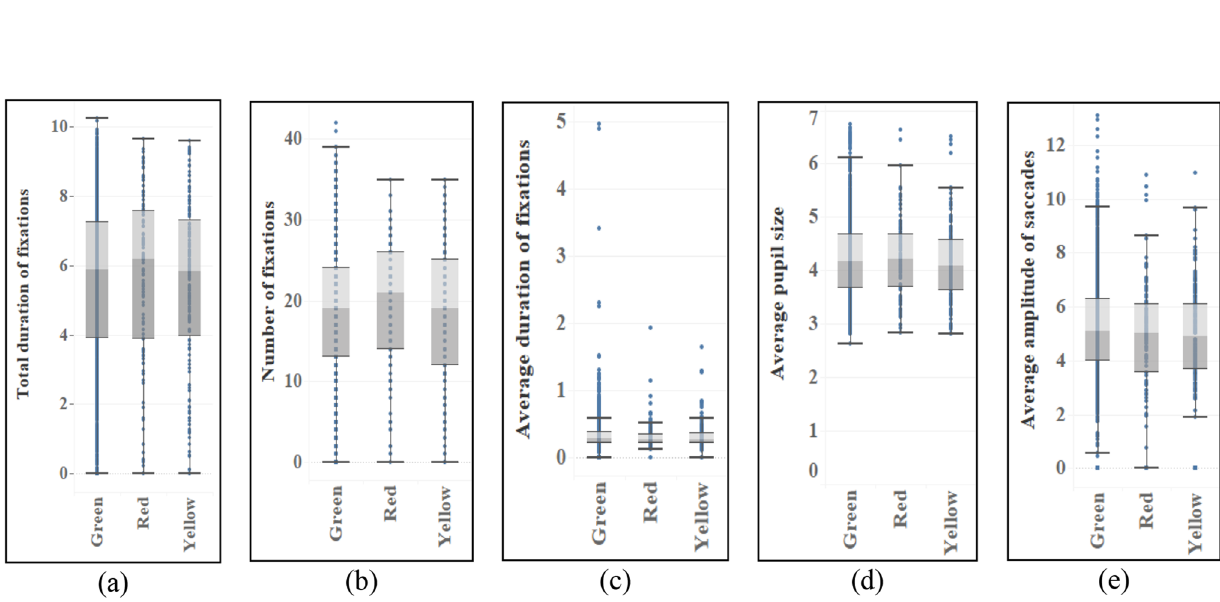
Figure 5. Eye movement index of different leaf